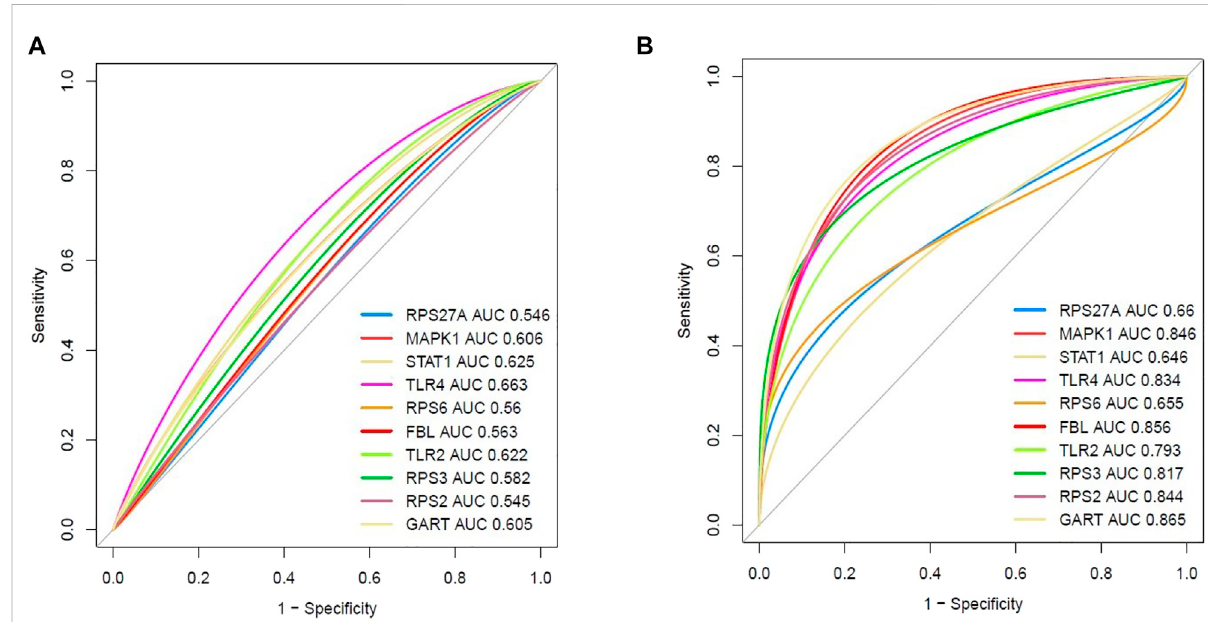
FIGURE 9 Evaluation of diagnostic ef fi cacy of essential hub genes. (A) The receiver operating characteristic (ROC) curve of the top ten hub genes in peripheral blood of PAH patients relative to the normal blood cells (integrated four datasets). (B) Validation of the receiver operating characteristic (ROC) curve of the top ten hub genes in peripheral blood